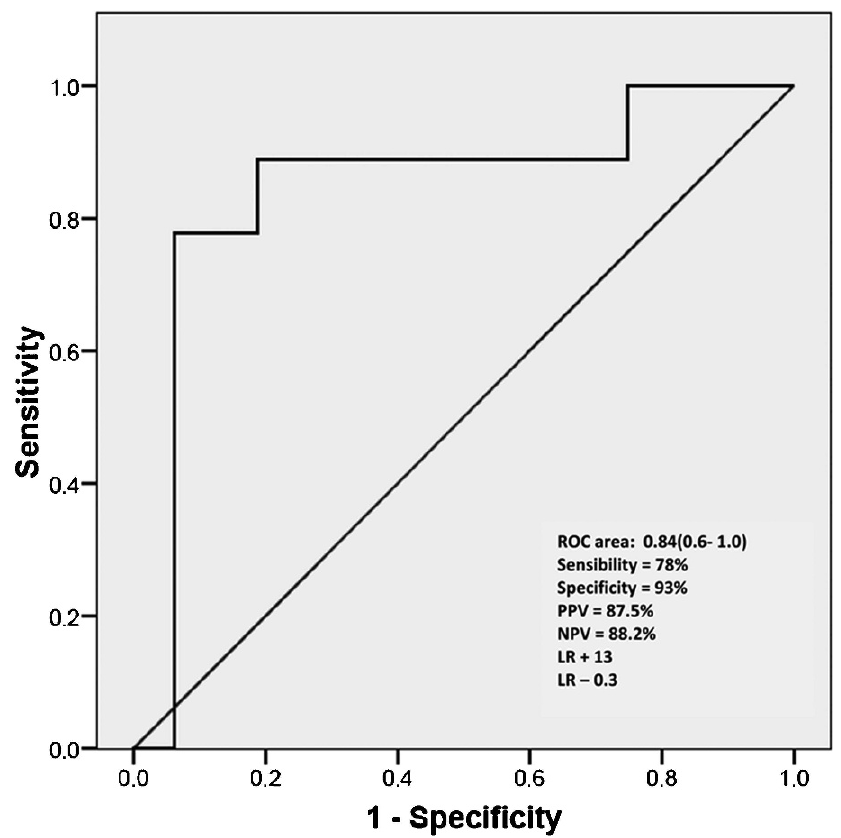
Figure 3 - Receiver operating characteristic curve for pulse pressure variation ( D RESP PP) in patients with septic shock ventilated with low tidal volumes. A cut-off value of 10% improved the negative predictive value (NPV) and positive predictive